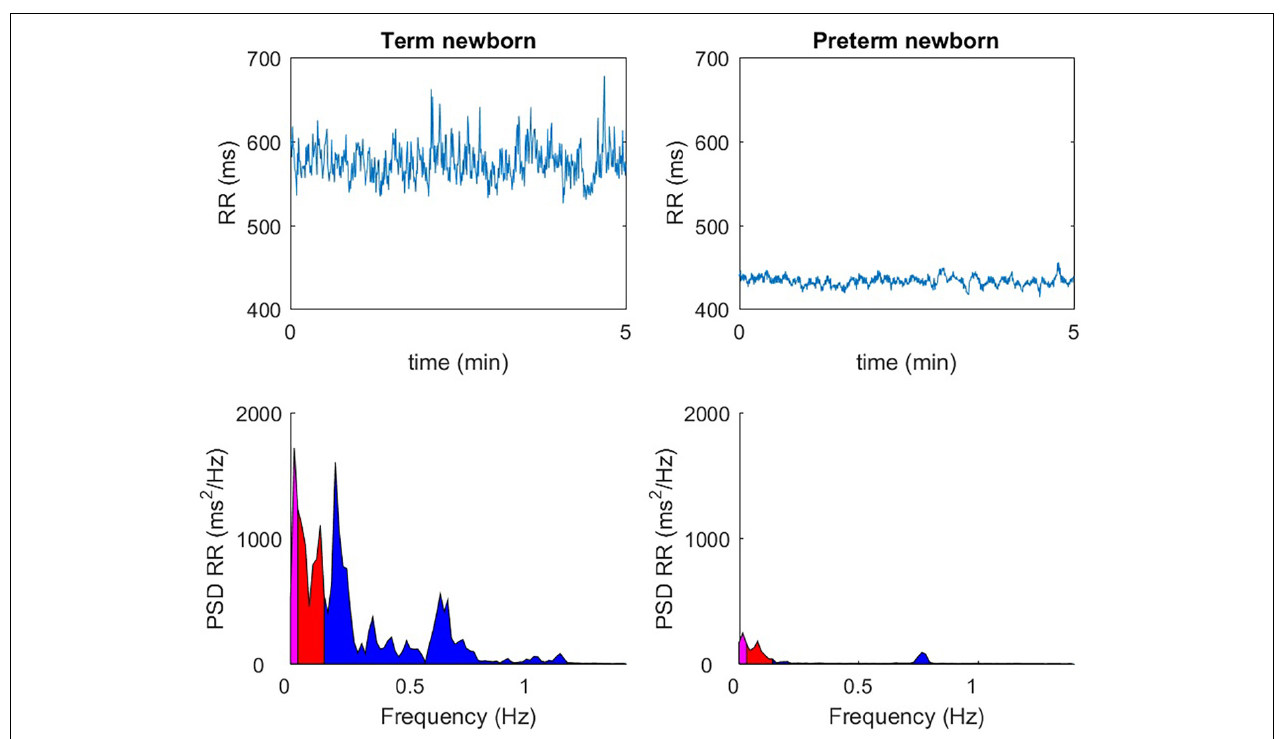
FIGURE 2 | The observable difference over 5 min in quiet sleep, between a full-term newborn (40 wGA) and a premature newborn (36 wGA), with a temporal analysis (ms) of the RR spaces (top windows), or with a frequency domain representation (ms2 / Hz) (bottom windows).